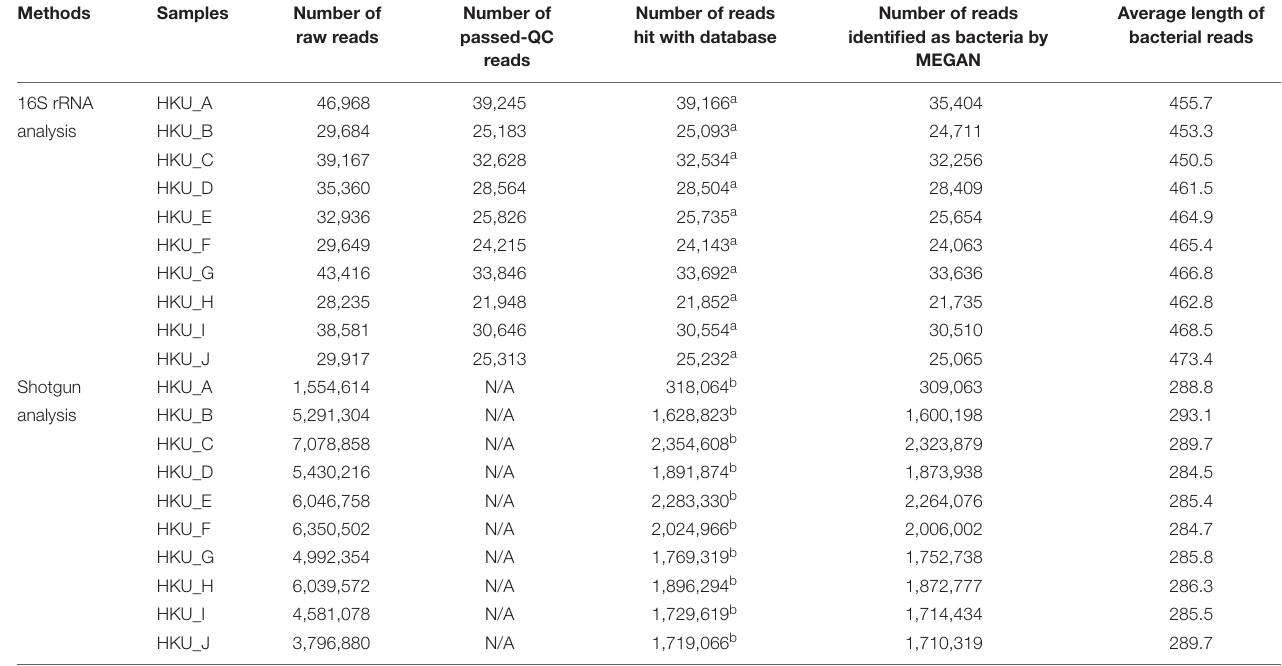
TABLE 1 | Summary of next generation sequencing